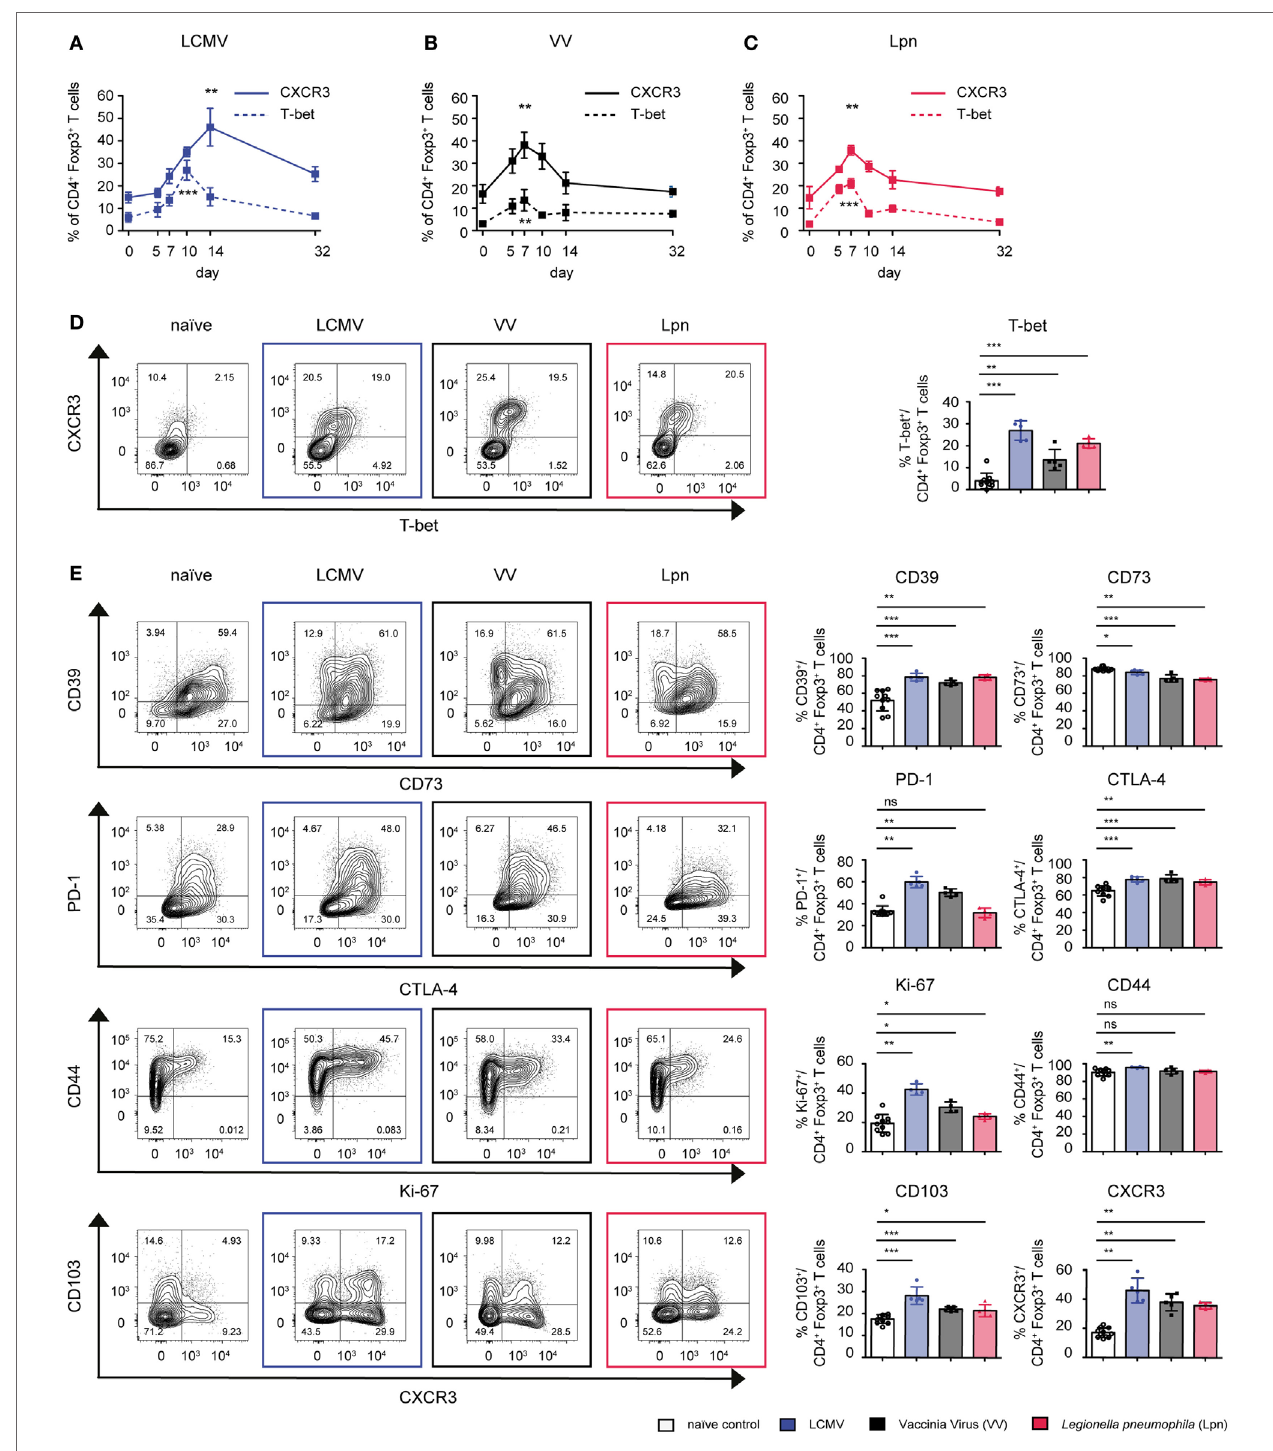
FigUre 1 | CD4 + Foxp3 + Treg cells specialize into T-bet + CXCR3 + Treg cells during Th1-dominated infections. C57BL/6 mice were acutely infected with LCMV WE (blue), Legionella pneumophila (Lpn, red), Vaccinia Virus (VV, black), or left naïve and expression of T-bet and CXCR3 (a–D) or the cell surface markers CD39, CD73, CTLA-4, PD-1, CD103, and activation/proliferation markers CD44 and Ki-67 (e) among live CD4 + Foxp3 + Treg cells was determined by flow cytometry. (a–c) Frequencies of CD4 + Foxp3 + CXCR3 + or CD4 + Foxp3 + T-bet + Treg cells over time and (D,e) peak expression levels of the indicated markers among splenic CD4 + Foxp3 + Treg cells and representative FACS plots at the peak of activation (Lpn: days 5–7; VV: days 7–10; LCMV: days 10–14) or in naïve controls are depicted [mean ± SD, naïve: n = 10, Lpn, VV, LCMV: n = 4–5, biological replicates; plots display one representative of > 3 independent experiments; * p < 0.05, ** p < 0.01, *** p < 0.001 (Mann–Whitney